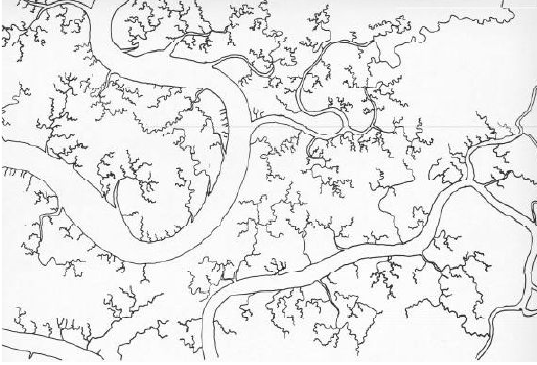
Figure 3. Typical Tidal Flood Pattern in Myanmar